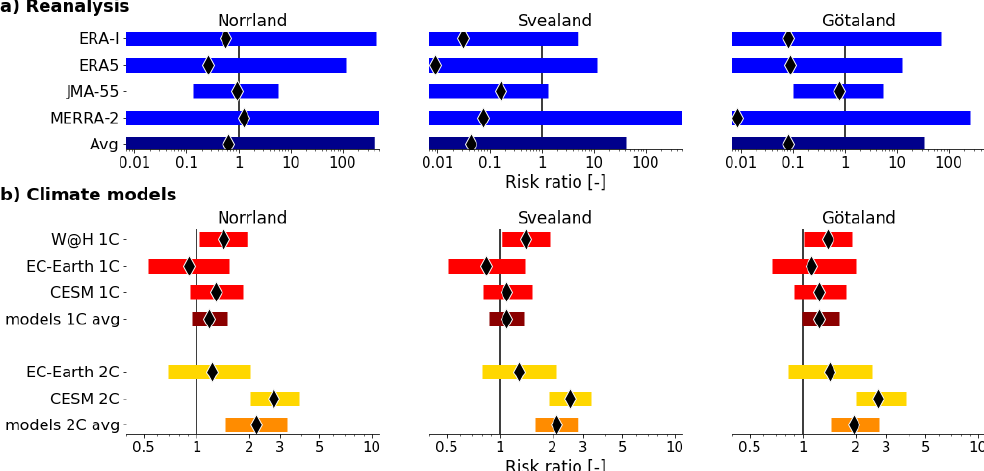
Figure 7. Probability ratios for maximum July–August FWI values as high as observed in 2018 for the different regions for (a) reanalysis and (b) climate models. All probability ratios are relative to PI climate. Note the different scales between (a) and (b) on the x axis.